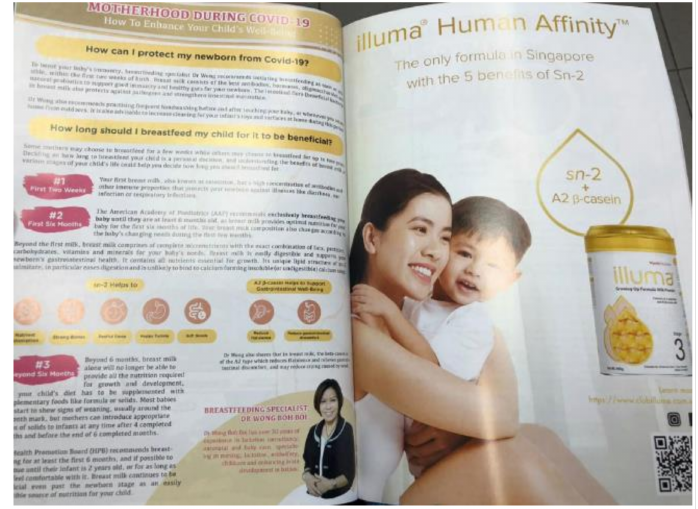
Figure 8. Image of Nestl é ’s advertisement of Illuma 3 from Mummys Market Pregnancy and Baby Guide in Singapore. Next to the advertisement was ‘information’ that highlighted “motherhood during COVID-19” and breastfeeding.